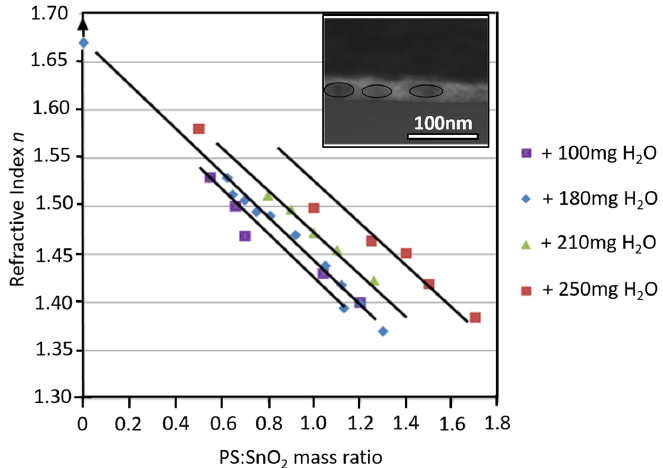
Figure 5. The index trend of SiO 2 nanoparticle films with increasing polystyrene solution mass ratio. There are two distinct trends, a sharp decrease in index with minimal introduction of PS, and a gradual decrease in index with significant introduction of PS. Inset: the refractive indices as a function of the estimated PS–SiO 2 particle ratio. Reproduced from [13] (copyright permission). The other inset shows the cross ‐ sectional SEM image of the void filled silica particle film.